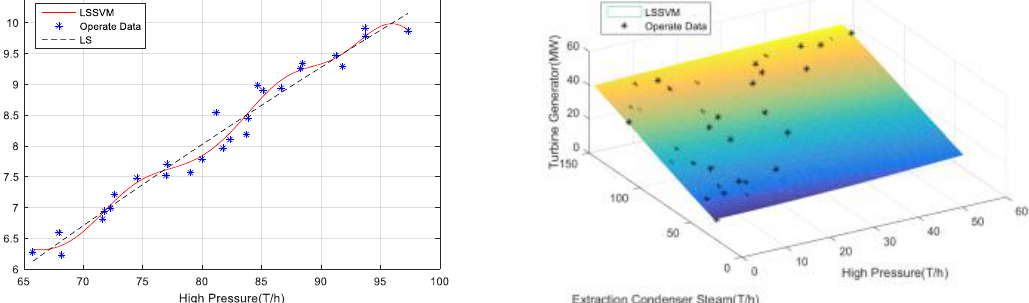
Table 6. Dispatch results at different TOU intervals. TOU